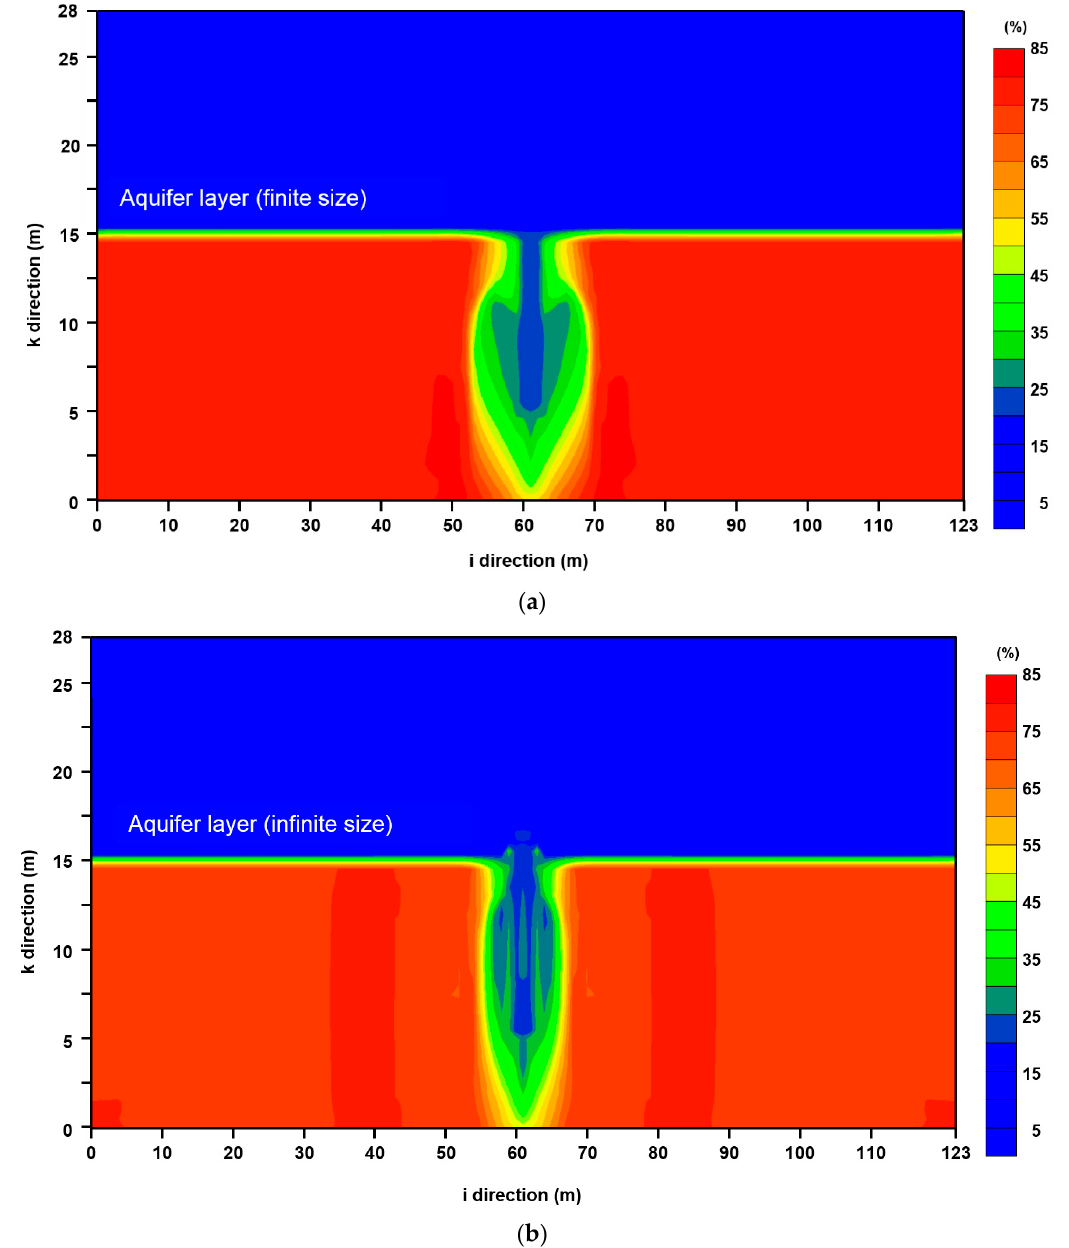
Figure 5. Oil saturation at the end of production in the cases of: ( a ) the finite aquifer; and ( b ) the infinite aquifer.